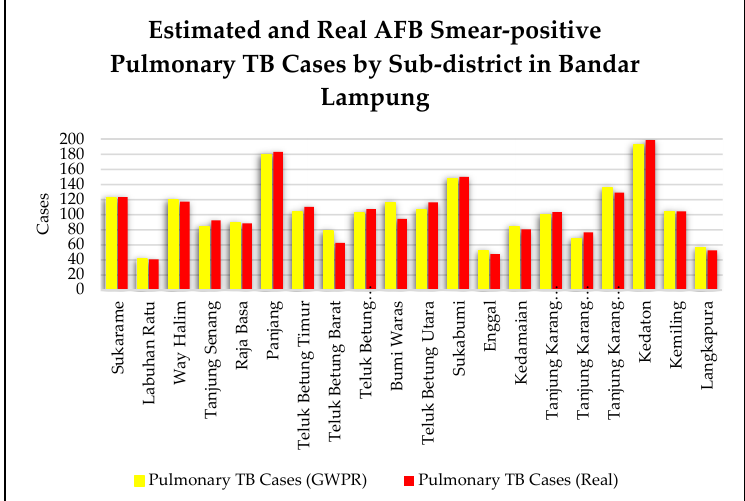
Figure 4. Estimated and real AFB smear-positive pulmonary tuberculosis (TB) by sub-districts in Bandar Lampung.